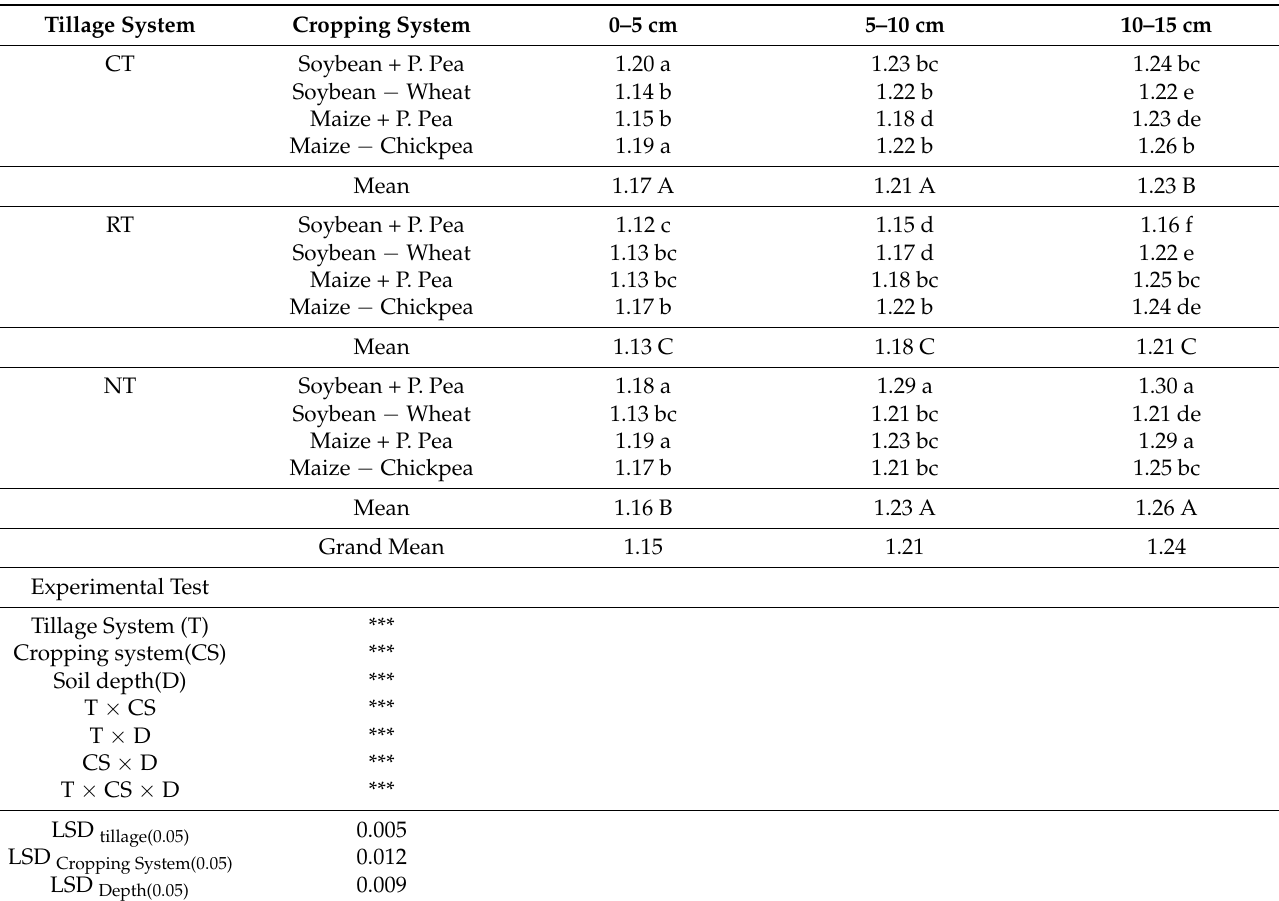
Table 2. Effect of different tillage and cropping systems on soil bulk density (Mg m − 3